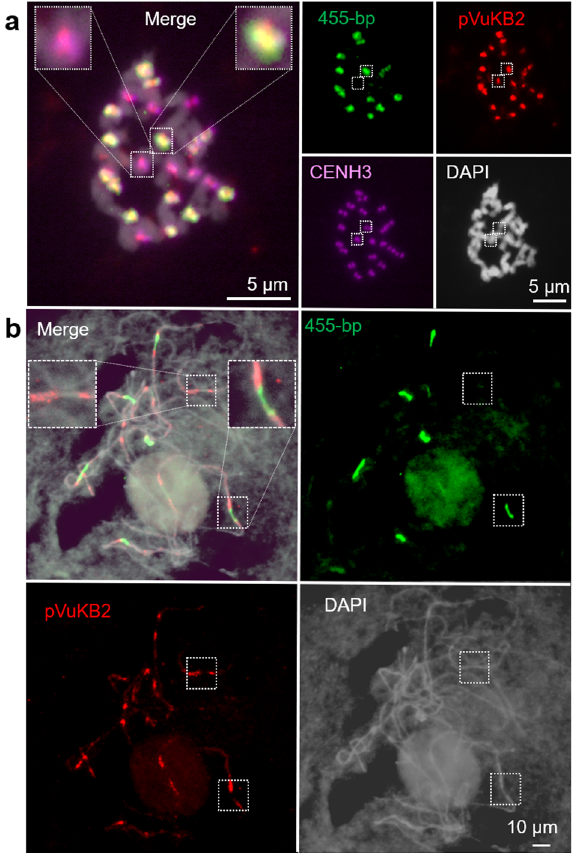
Fig. 7 Sequence composition of cowpea centromeres in mitotic and meiotic cells determined by FISH. a In total, 14 out of 22 centromeres are enriched in the 455 bp (green) tandem repeat, and all centromeres contain the pVuKB2 (red) tandem repeat. The position of functional centromeres was con fi rmed by cowpea CENH3 immunostaining (magenta). b pVuKB2 signals (red) are fl anked by 455 bp tandem repeats (green) in naturally extended pachytene chromosomes. Further enlarged centromere regions are shown as inserts in merged